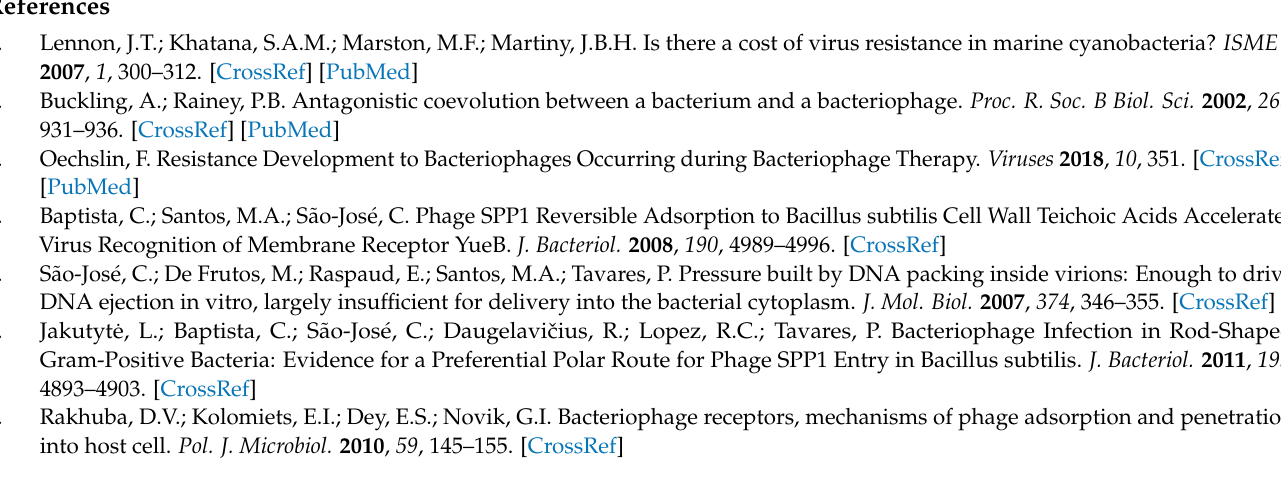
Supplemental Data 2. Biological characterization of bacteriophage Ares1; Figure S1. Growth kinetics of phage-resistant and phage-susceptible strains in detail. Table S1. Relative transcript abundance of genes studied. Table S2. Primer list for the real-time qPCR platform. Table S3. List of polymorphisms that were localized in the three respective resistant